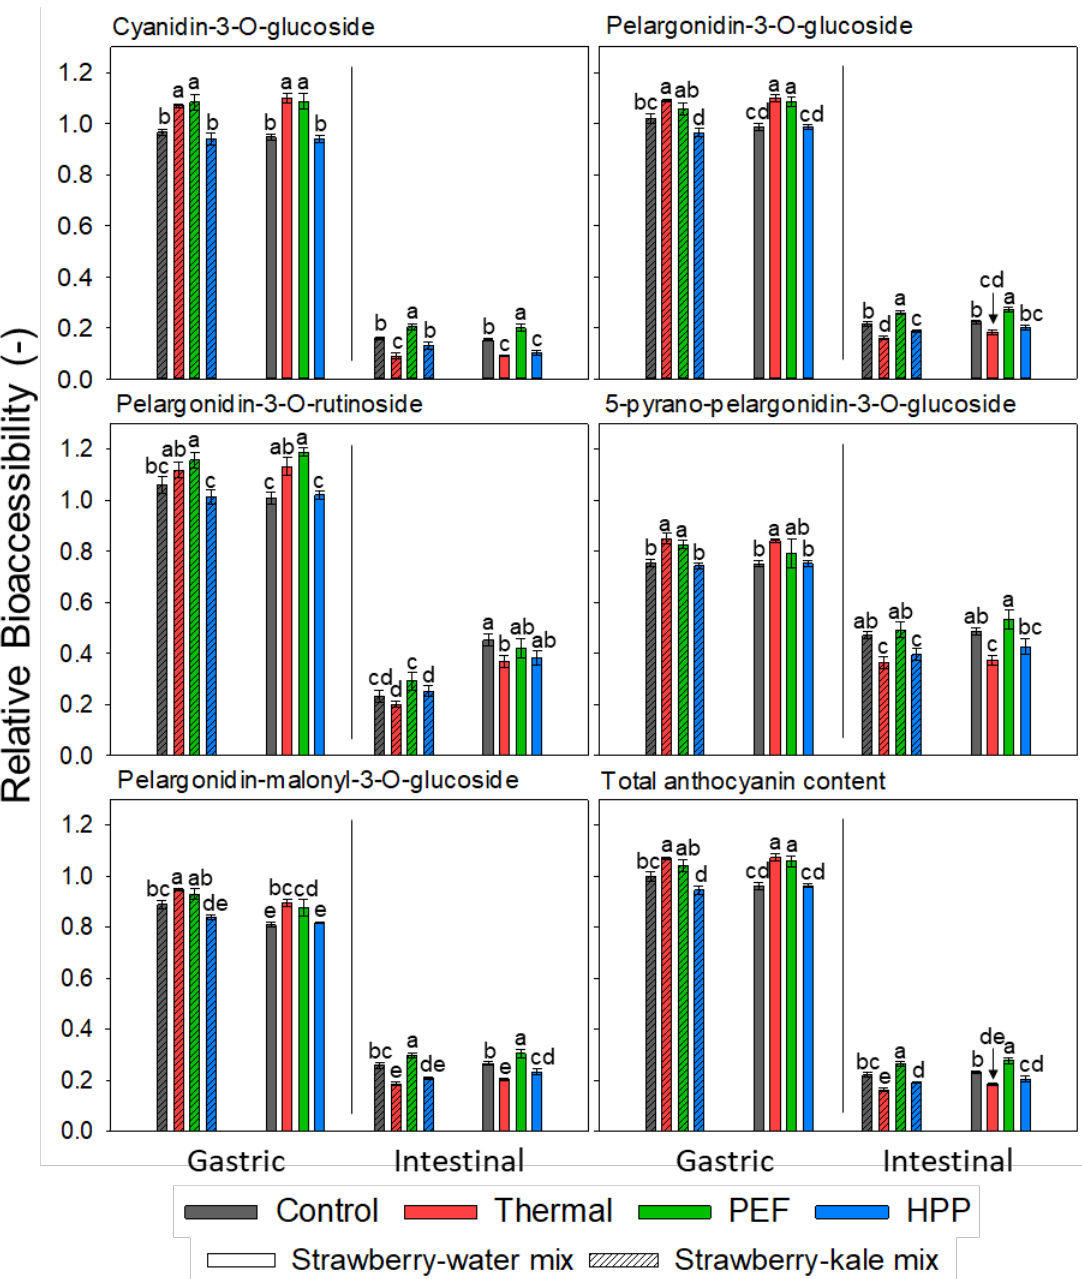
Figure 7. Bioaccessibility (compared to the initial content of the extracted untreated strawberry) of the anthocyanins after processing. Different letters indicate significant differences per anthocyanin and per bioaccessibility (gastric and intestinal) ( p < 0.05, n = 4).